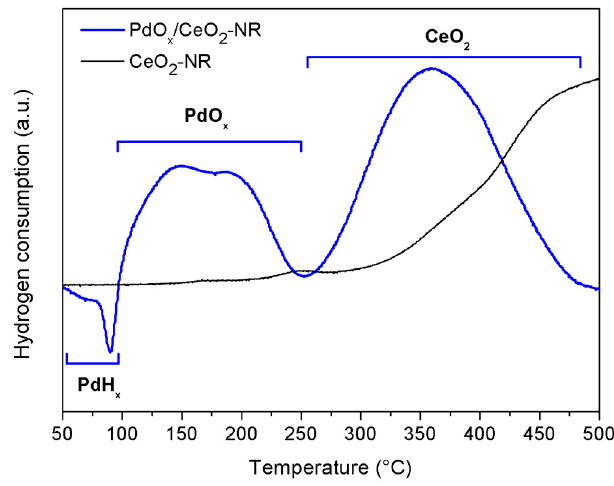
Figure 2. Temperature programmed reduction (H 2 -TPR) profiles of the samples: CeO 2 -NR and PdO x /CeO 2 -NR.